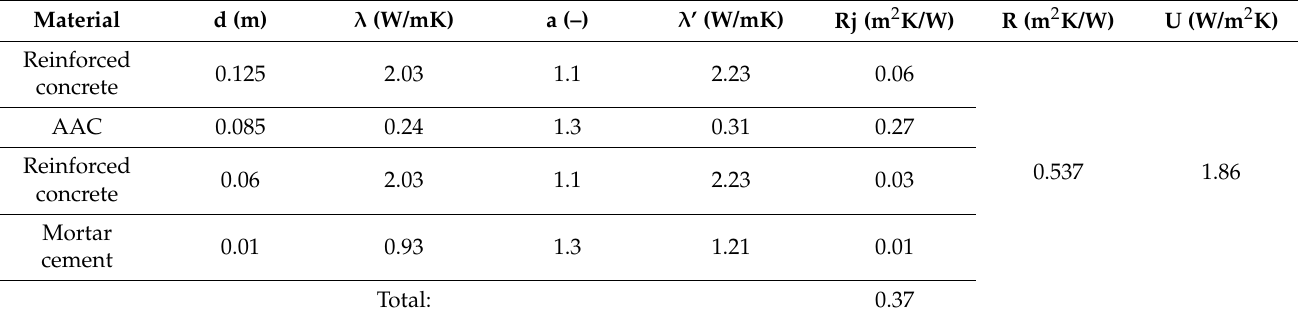
Table 4. Calculated value of the thermal